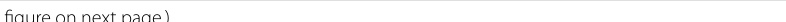
figure on next Fig. 5 In vivo fluorescence images after different solutions were injected via the tail vein. a Fluorescence images of whole animals injected via the tail vein with 200 μg/ml DZP-CHP or PS-DZP-CHP nanoparticles loaded with ICG as a stain. a Free ICG solution (fluorescence intensity b ICG-DZP-CHP nanoparticles (fluorescence intensity 10 7 ), c ICG-DZP-CHP nanoparticles modified by PS (fluorescence intensity × Fluorescence images of various organs after injection of DZP-CHP nanoparticles modified by PS via the tail vein. c Fluorescence images of the brain after dissection. d Brain of mice injected with ICG-PS-DZP-CHP nanoparticles, e brain of mice injected with ICG-DZP-CHP nanoparticles modified with PS, f brain of mice injected with free